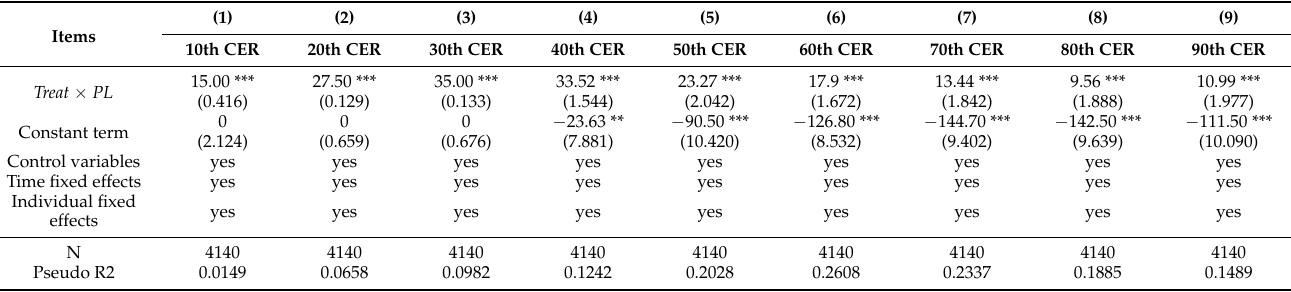
Table 7. CER estimation results at different quantile levels.